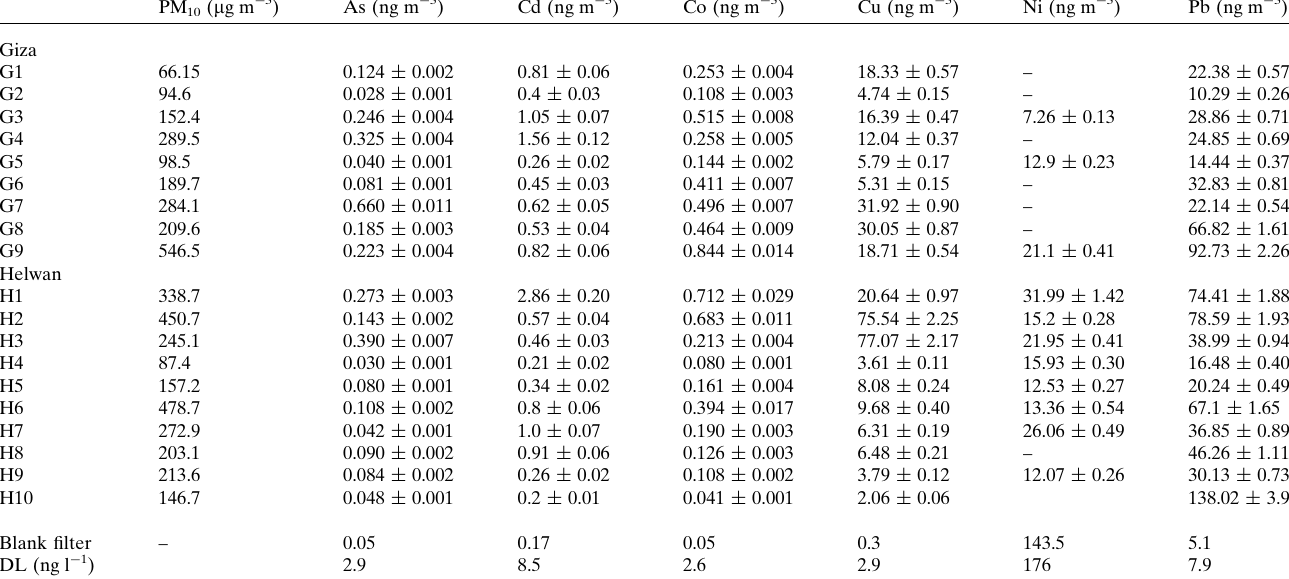
Table 2 Concentrations of toxic heavy metals (ng m (cid:3) 3 ) associated with PM 10 ( m g m (cid:3) 3 ) at the Giza and Helwan stations, as well as the detection limit (DL) of the ICP-MS (ng l (cid:3) 1